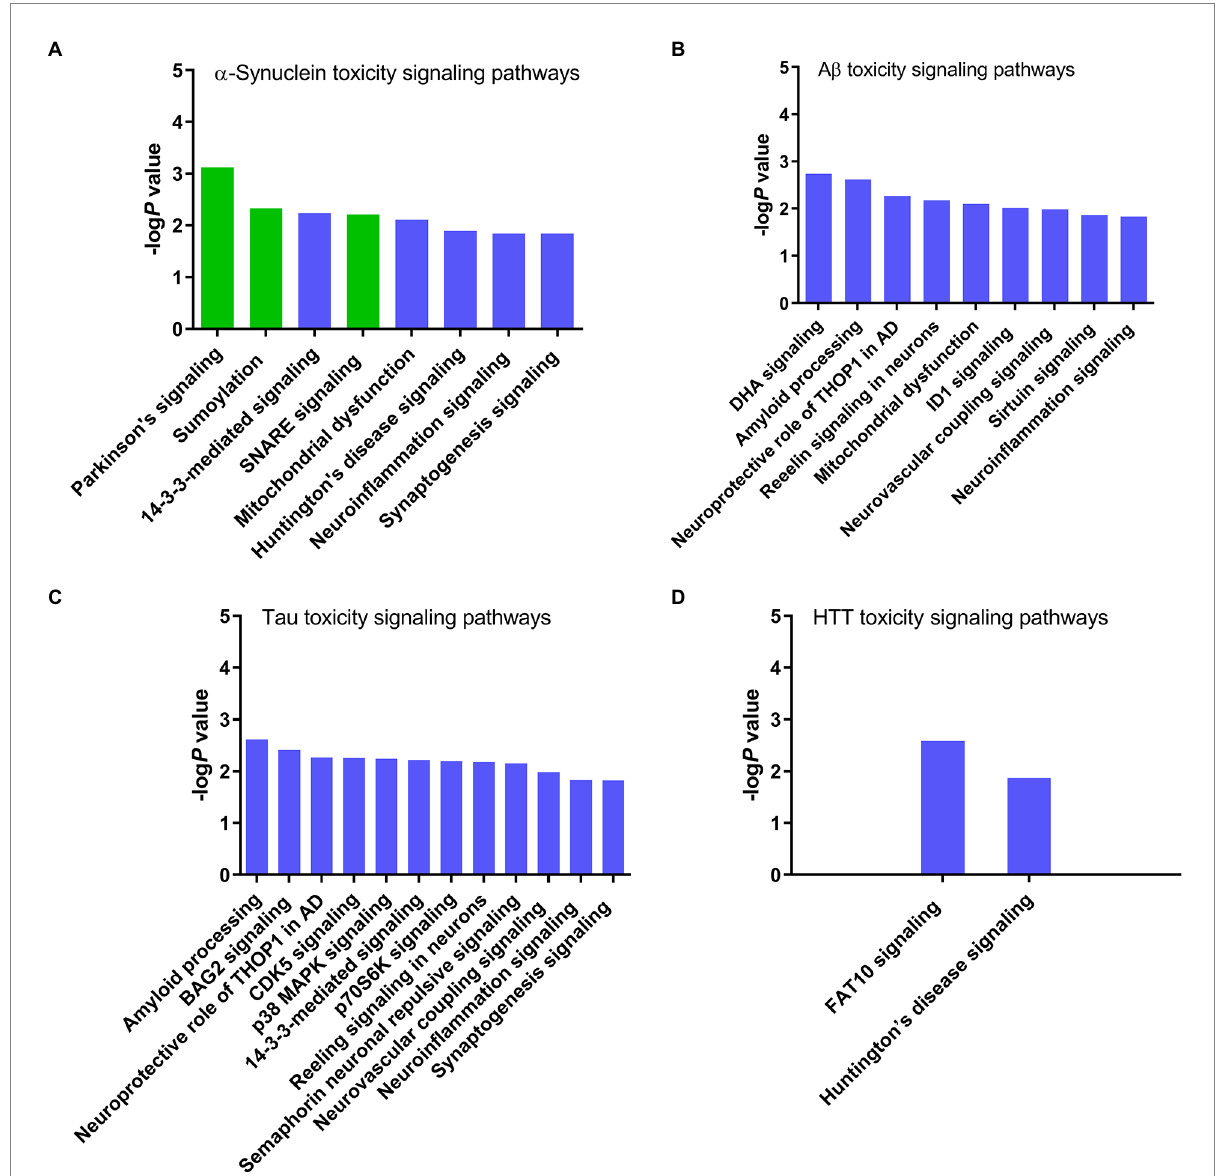
FIGURE 4 Canonical signaling pathways associated with the toxicity of neurodegenerative proteins predicted by IPA. (A) α -Synuclein, (B) Amyloid beta, (C) Tau, and (D) Huntingtin. IPA toxicity analysis identified Parkinson’s, sumoylation, and SNARE signaling pathways specific to the α -synuclein toxicity. Conversely, α -synuclein shares 14–3-3, mitochondrial dysfunction, Huntington’s disease, neuroinflammation, and synaptogenesis signaling pathways with other neurotoxic proteins amyloid beta, tau, and HTT, suggesting that these pathways are likely activated due to the host cell stress response or secondary non-specific response to the toxicity of α